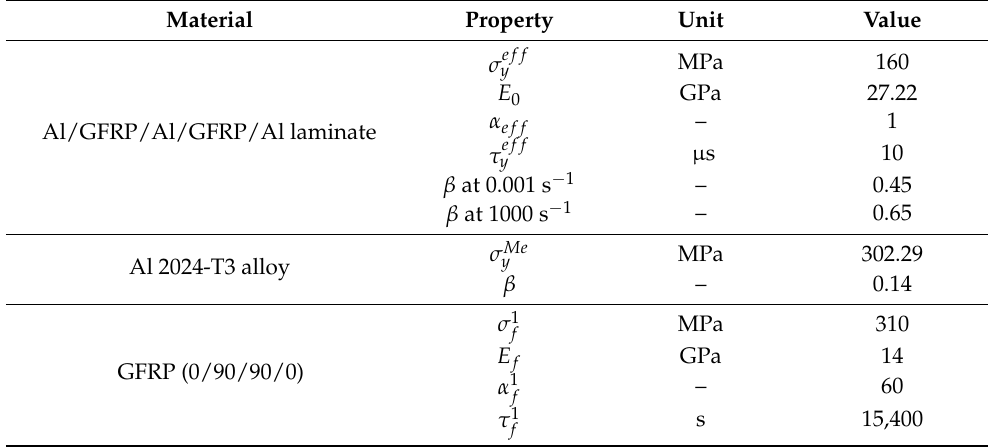
Table 4. Parameters of the model and materials [19,20] for the calculated deformation curves of the GLARE Al/GFRP/Al/GFRP/Al composite in Figure 3a.